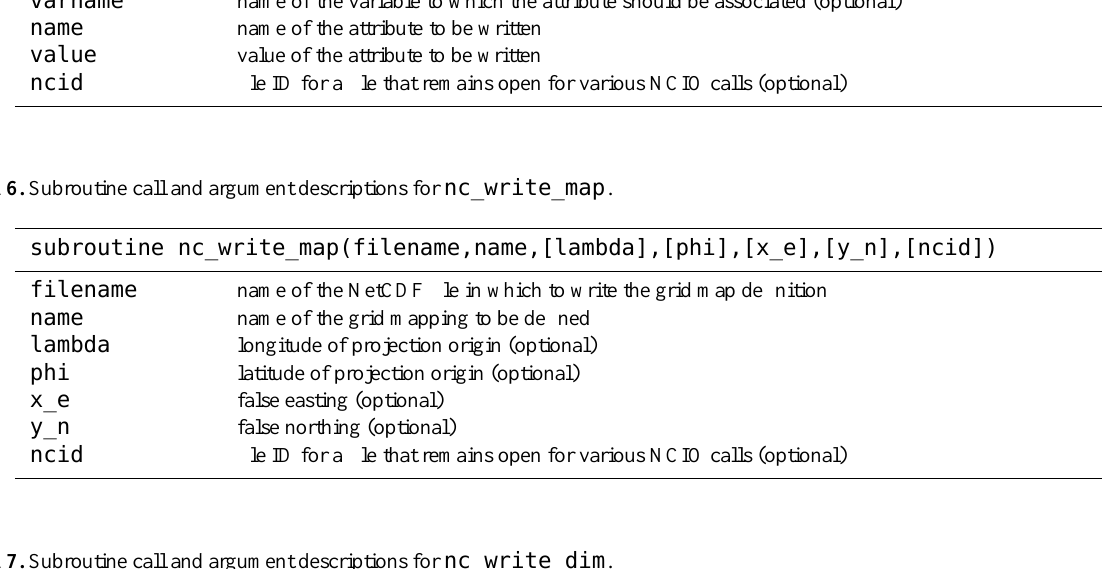
Table A7. Subroutine call and argument descriptions for nc_write_dim